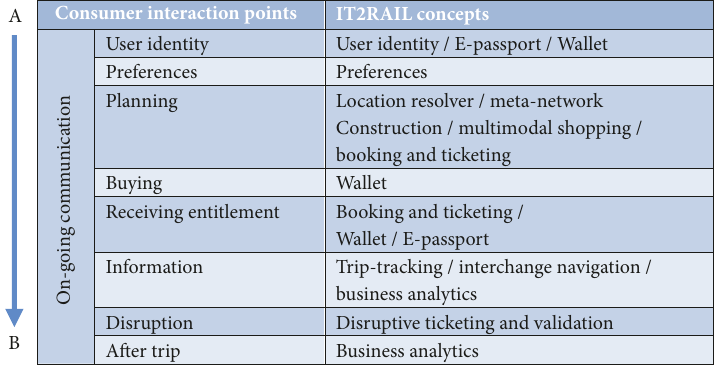
Figure 1: Overview of TC consumer interaction points & corresponding IT2Rail